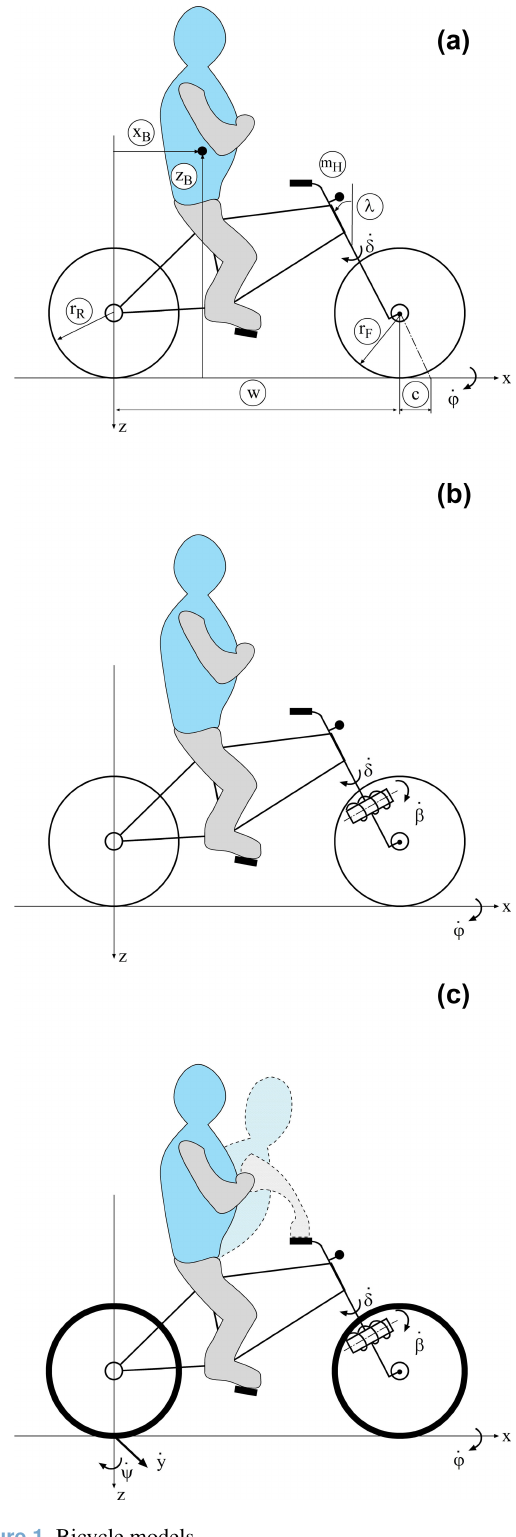
Figure 1. Bicycle